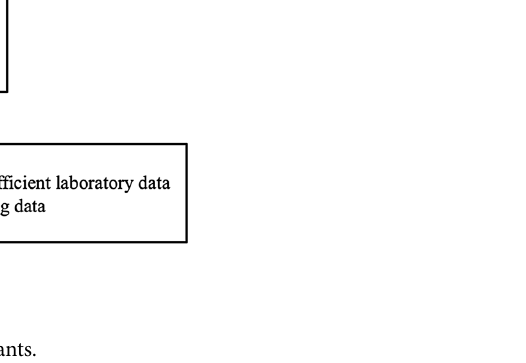
Figure 1. Flow chart of the study